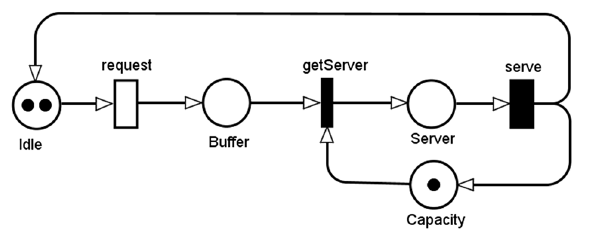
Figure 2: The Petri net model of M/D/1/2/2 sys-